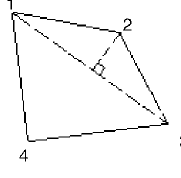
Figure 10 Case 3: extreme vertexes.